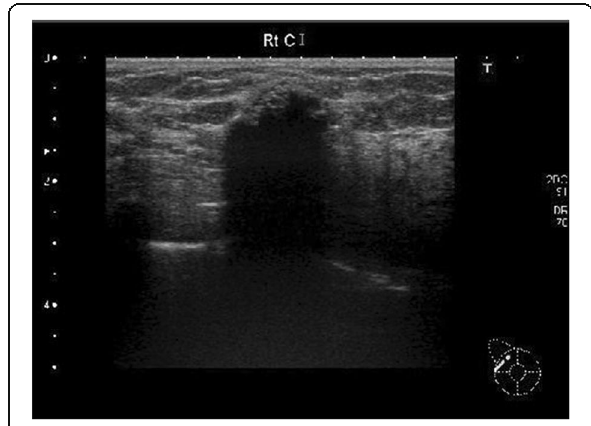
Fig. 2 Ultrasonography. A 1.7-cm-diameter relatively smoothly marginated hypoechoic mass containing multiple